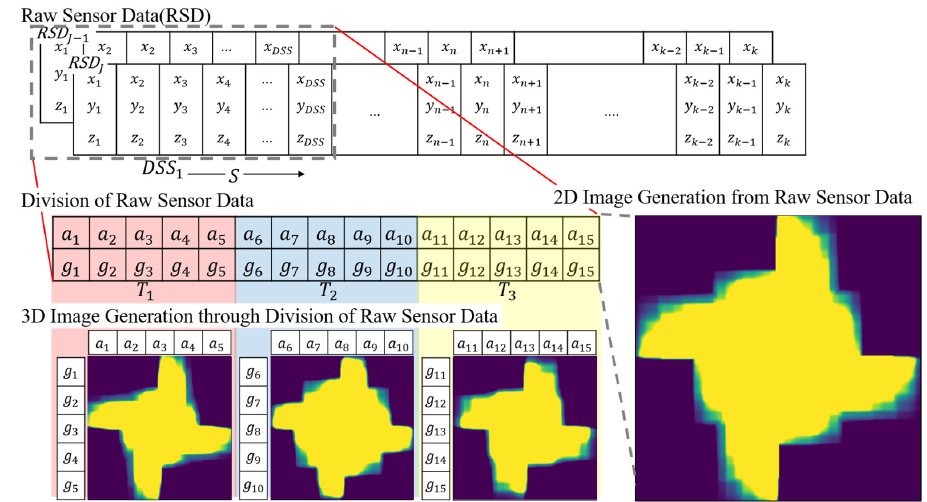
Figure 10. 3D Visualization processing concept from 𝐵𝐼𝐷𝑃 of raw sensor data (J is no. of datasets).